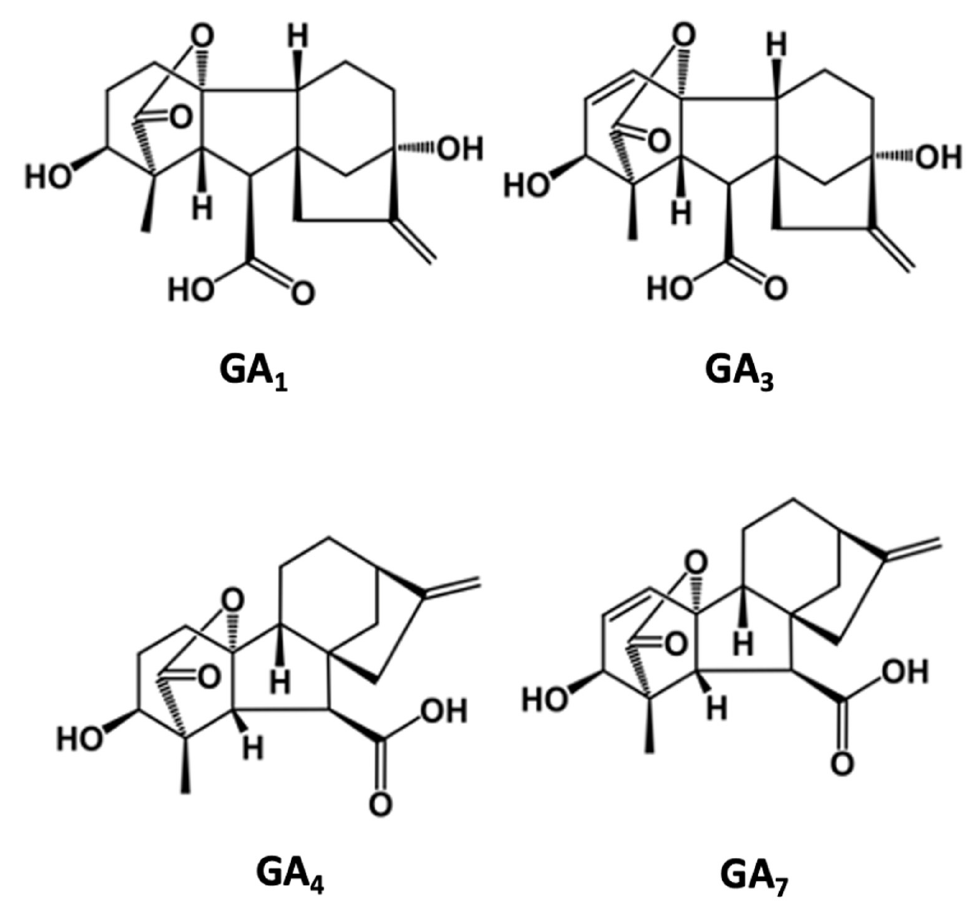
Figure 2. Chemical structures of bioactive gibberellins.